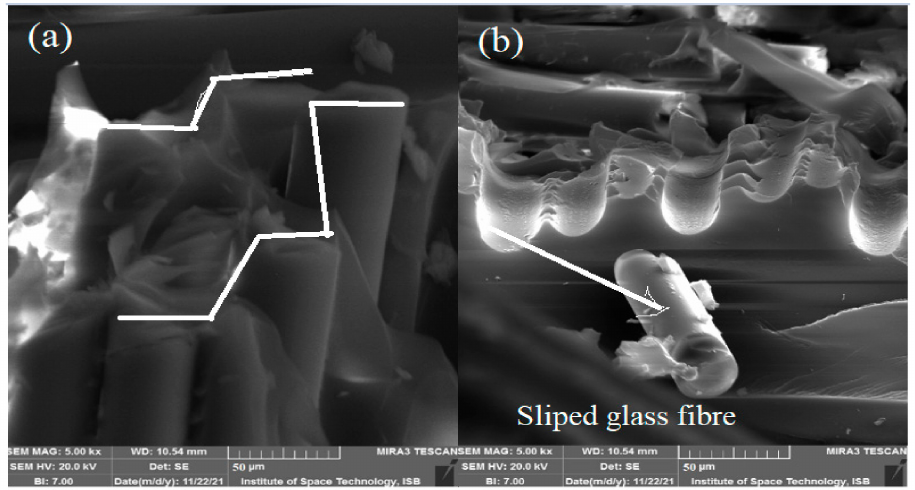
Figure 12. SEM image of 32% glass fiber. ( a ) Stepwise breaking of glass fiber ( b ) Glass fiber